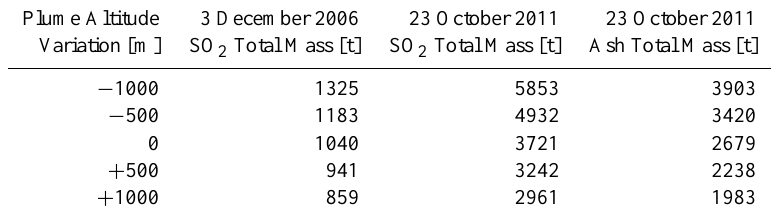
Table 5. SO 2 and ash total masses computed using the VPR procedure for different plume altitudes and temperatures. Plume